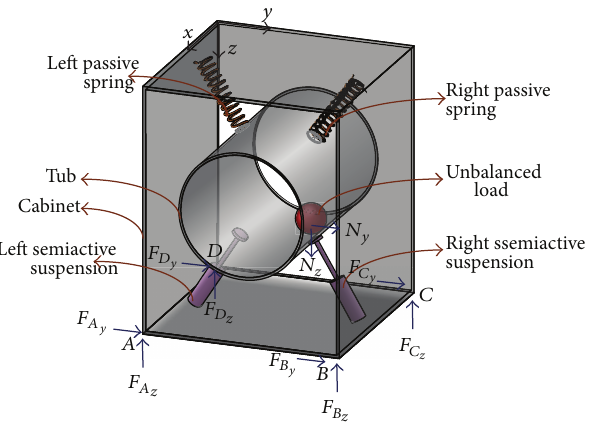
Figure 1: Forces acting on washing machine.